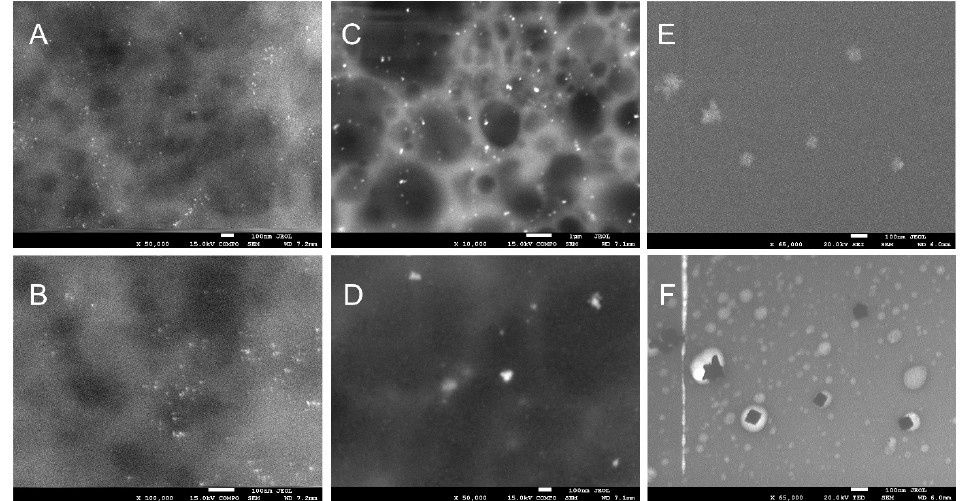
Figure 2. SEM micrographs of foils taken at different magnifications: ( A , B ) Ag-xylose (50,000 ( A ) and 100,000 ( B ) magnification ); ( C , D ) Ag-maltose 10,000 ( B ) and 50,000 ( C ) magnification); ( E , F ) Ag-glucose 65,000 magnification ( E , F ).